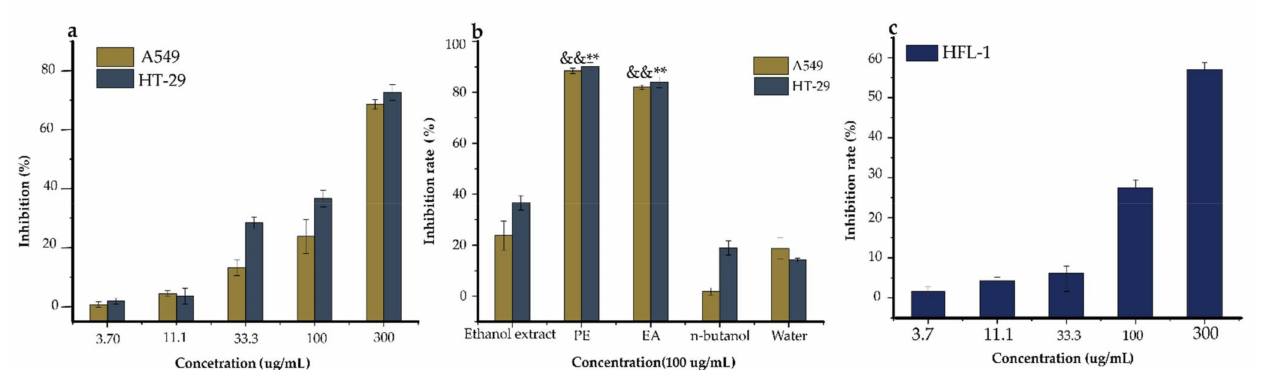
Figure 4. The antiproliferative activity of the ethanol extracts, PE (petroleum ether), EA (ethyl acetate), n -butanol, and water fractions of Ficus glumosa . ( a ) The (%) inhibition rates of HT-29 and A549 cells by different concentrations of ethanol extracts of Ficus glumosa. ( b ) The % inhibition rates of A549 and HT-29 cells treated with ethanol extracts, PE, EA, n -butanol, and water fractions of Ficus glumosa . ( c ) The toxicity of ethanol extracts of Ficus glumosa on normal lung (HFL-1) cells. && p < 0.01, ** p < 0.01 when compared to ethanol